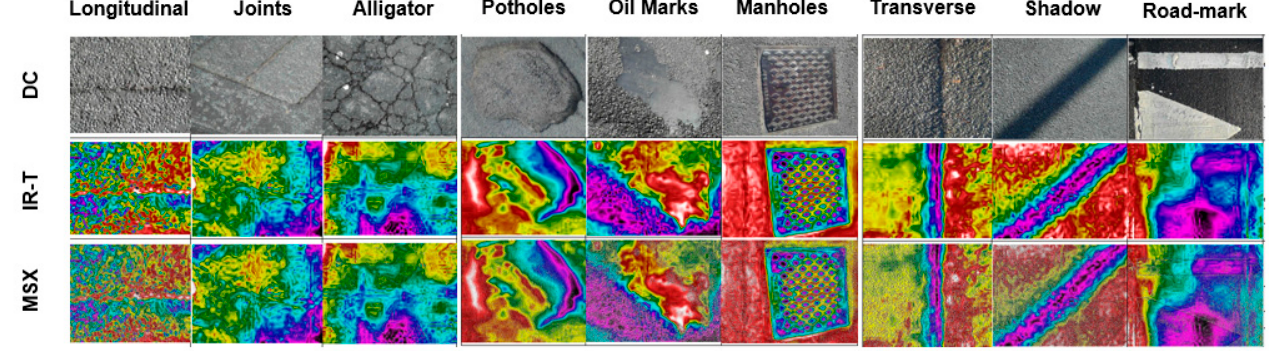
Figure 3. Sample image per category by image